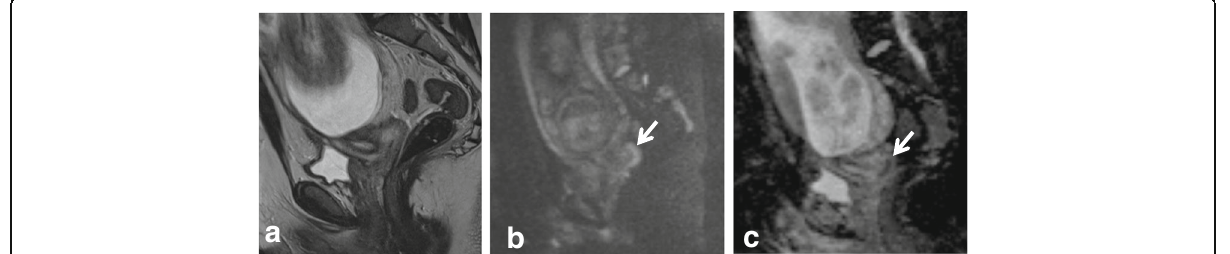
Fig. 12 Pregnant woman with biopsy-confirmed cervical cancer that is not detectable on T2WI ( a ), but is delineated (white arrows) on DWI images ( b , c